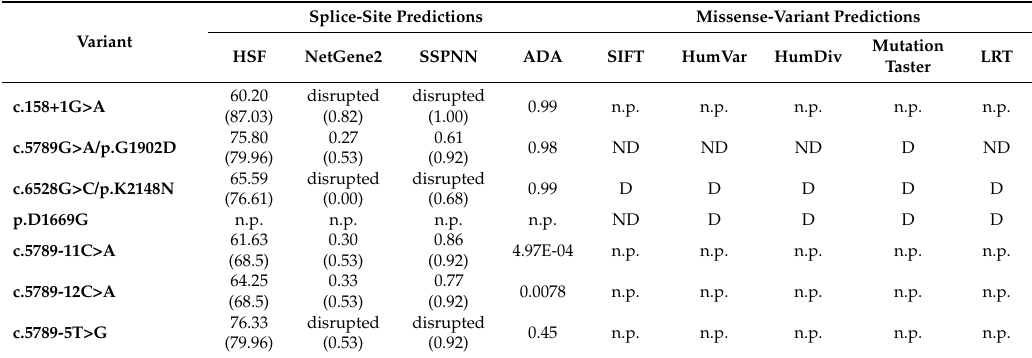
(Table 2). A summary of the in silico prediction analyses is reported in Table 3. Table 3. In silico predictions of the identified genetic